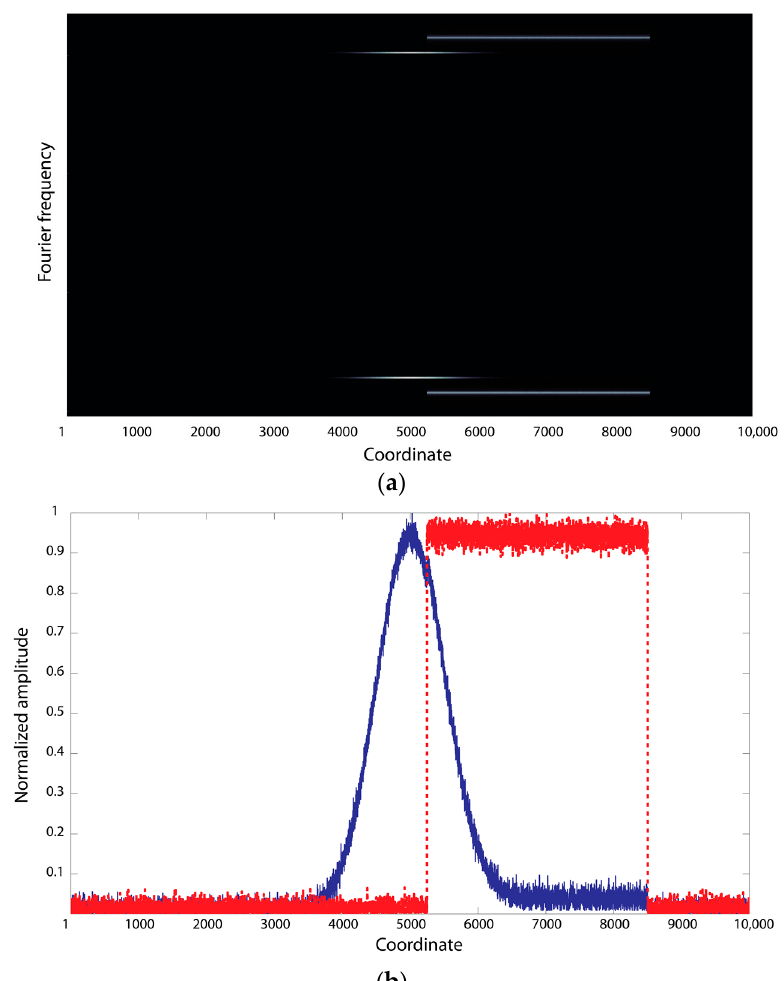
Figure 9. Reconstruction of 1D archetype shapes: ( a ) amplitude spectrum; ( b ) reconstructed profiles (different colours are used to distinguish between two reconstructed archetypes).